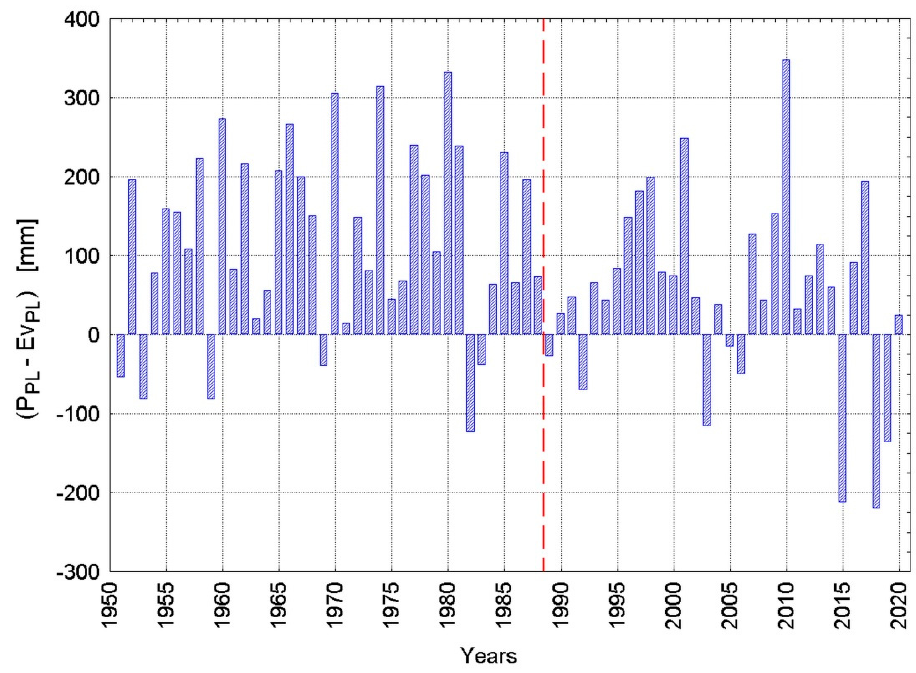
Figure 7. Values of the simplified annual area water balance (mm) in 1951–2020. The sub-periods 1951–1988 and 1989–2020 are separated with the vertical dashed line.